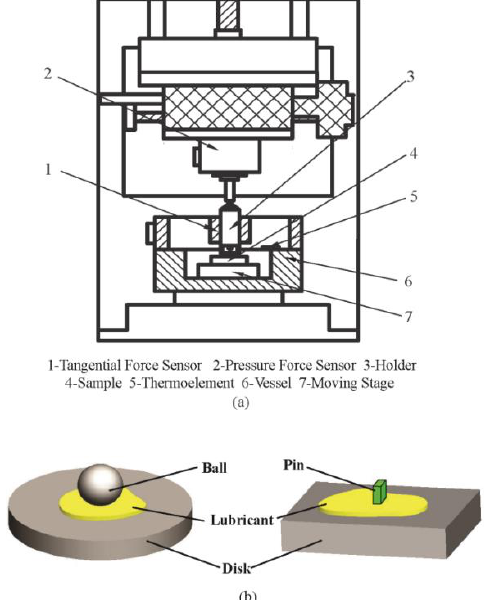
Figure 1. Schematic of the ( a ) testing system and ( b ) pin-on-disk and ball-on-disk configuration.